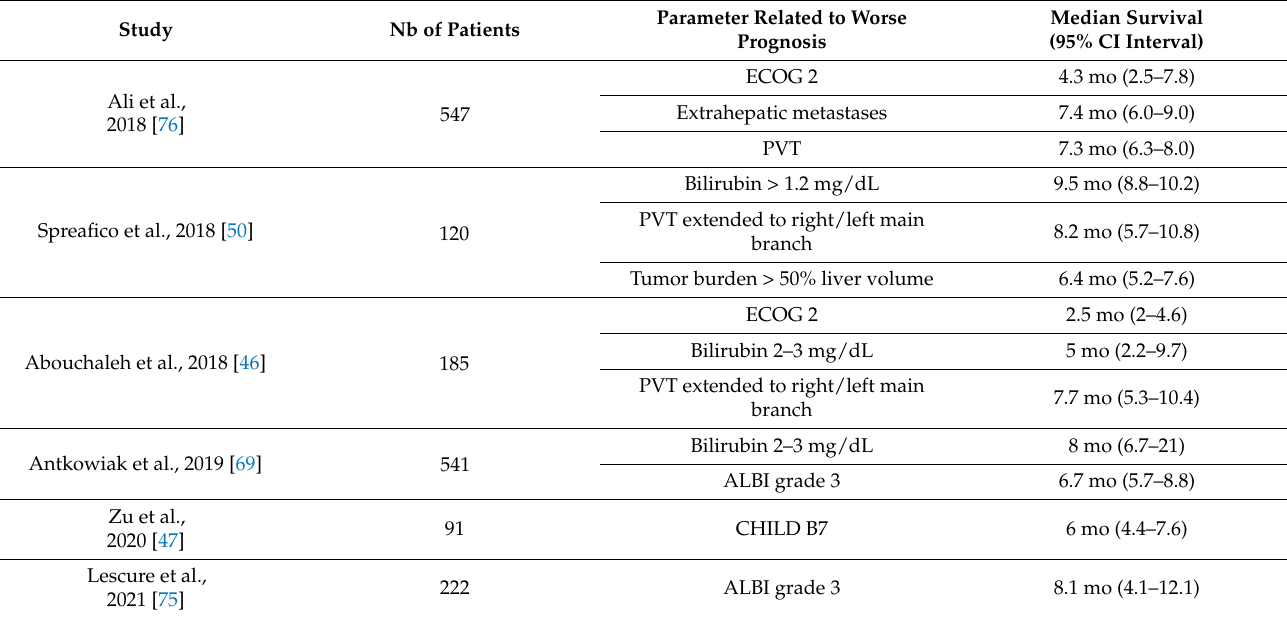
Table 6. Studies reporting factors of poor prognosis in advanced HCC treated by